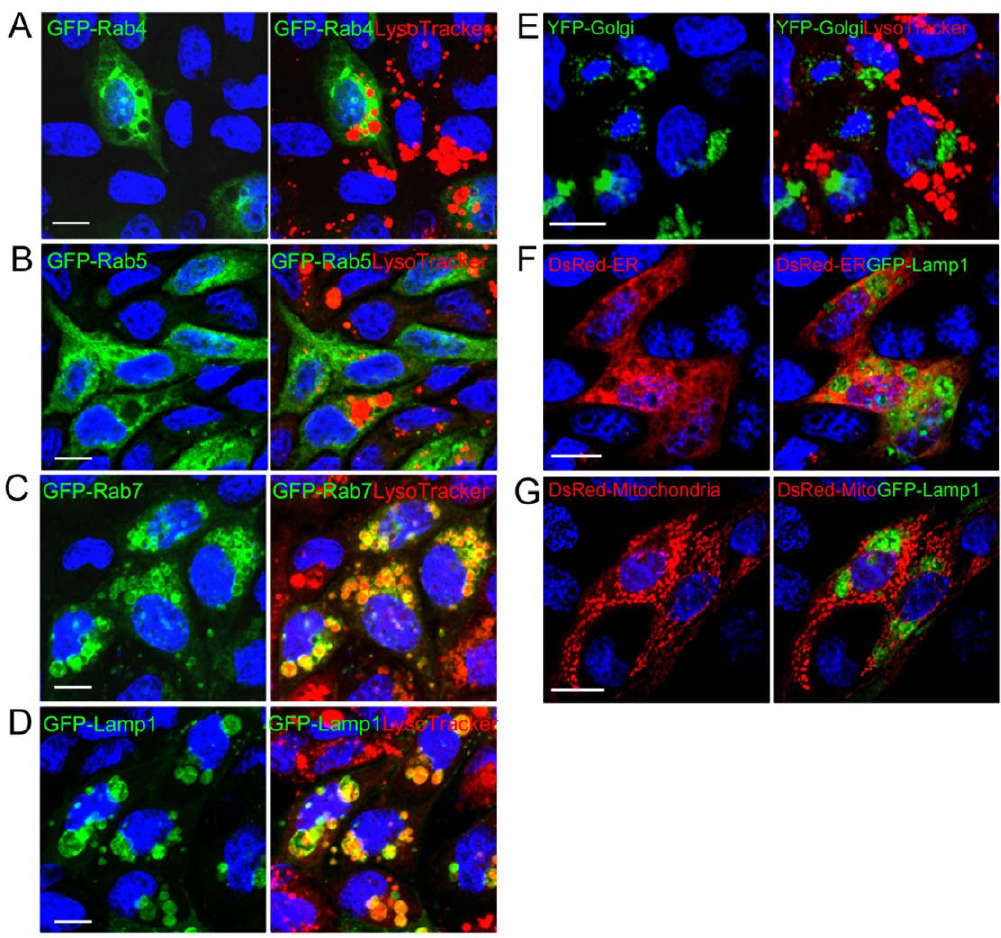
Figure 1. The giant vacuoles induced by Bin possess characteristics of late endocytotic and lysosomal compartments. (A-E) MDCK- Cpm1 cells were transfected with GFP-Rab4, GFP-Rab5, GFP-Rab7, GFP-Lamp1 or YFP-Golgi and treated with BinA and BinB for 6 h. LysoTracker (1 m M) was added to the medium 5 min before the end of the treatment. (F and G) MDCK-Cpm1 cells were co-transfected with DsRed2-Endoplasmic Reticulum or DsRed2-Mitochondria and GFP-Lamp1 before intoxication. Bin-induced vacuoles stained with LysoTracker or GFP-Lamp1 do not colocalize with marker of Golgi apparatus, ER and mitochondria. Bars, 10 m m.